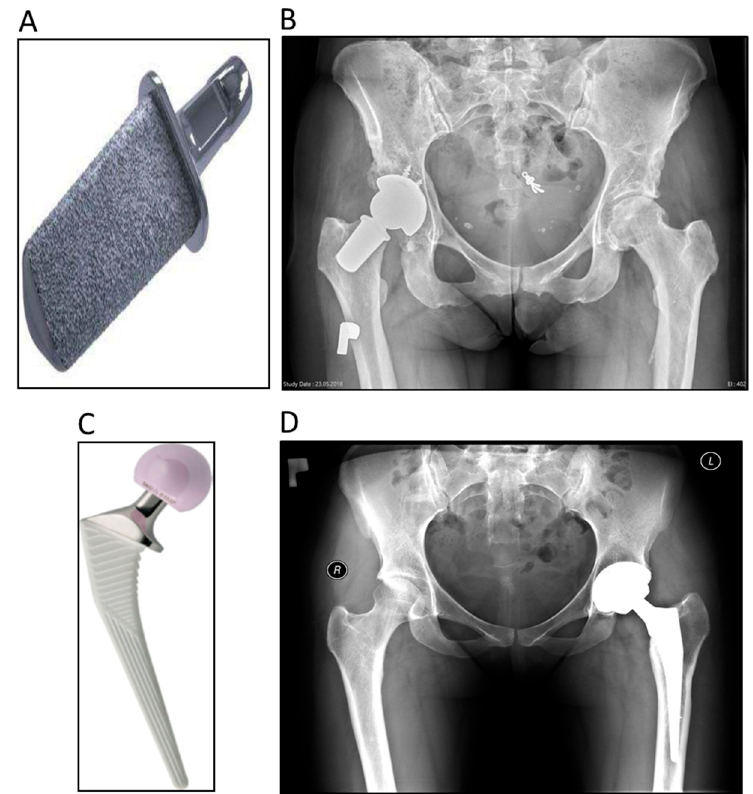
Figure 2. The femoral neck prosthesis (Biomet information materials) ( A ) and postoperative radiograph ( B ). The conventional hip stem system (DePuy information materials) ( C ) and postoperative radiograph ( D ).